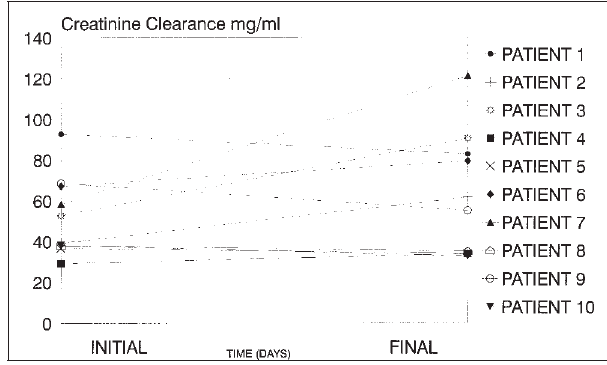
Mean changes in serum electrolytes and liver enzymes